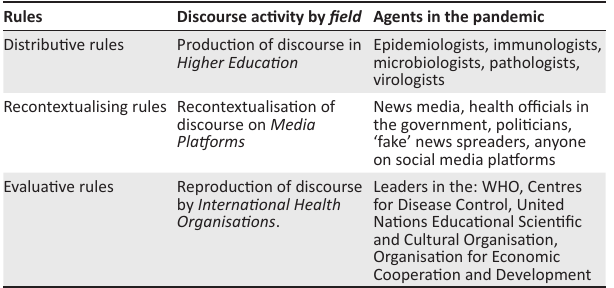
TABLE 7: Division of knowledge labour on personal health responsibility in a pandemic.